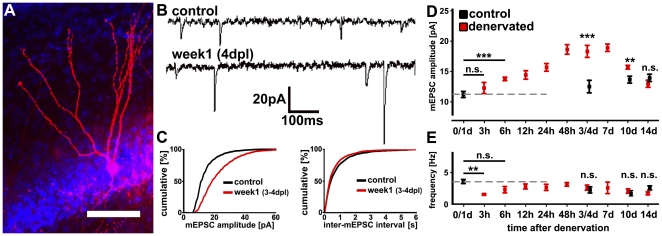
Denervation induces an increase in excitatory synaptic strength.(A) Granule cell in a denervated culture at 3–4 days post lesion (dpl). The neuron was filled with biocytin and post-hoc identified using Alexa568-conjugated streptavidin (red; blue, TO-PRO nuclear stain). Scale bar: 50 µm. (B) Sample traces of miniature excitatory post synaptic currents (mEPSC) recordings from non-lesioned control cultures and from denervated granule cells at 4 dpl. (C) Cumulative distribution diagrams of mEPSC amplitudes and inter-event intervals from control and denervated (3–4 dpl) dentate granule cells revealed a significant increase in amplitude after denervation. (D, E) mEPSCs were recorded at 3 h, 6 h, 12 h, 24 h, 48 h, 3–4 dpl, 7 dpl, 10 dpl and 14 dpl. Age-matched controls were recorded at 0–1 d, 3–4 d, 10 d and 14 d (n = 4–11 cultures per group; ≥3 neurons per culture; 165 neurons total). These experiments demonstrated increased mEPSC amplitudes between 6 h and 10 dpl (D). The frequency of mEPSC events was initially decreased (at 3 h post lesion) and subsequently recovered back to control levels (E).